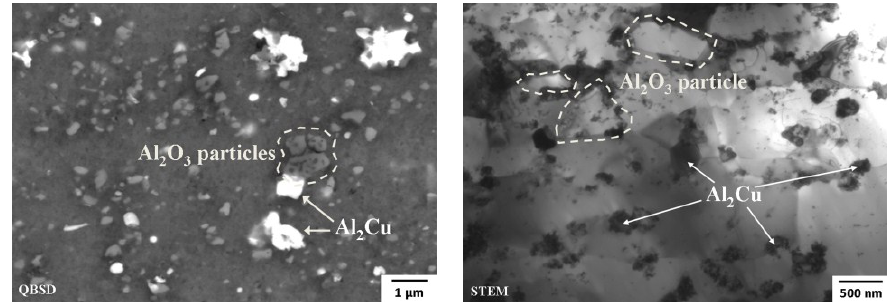
Figure 2. Electron back scatter diffraction (EBSD) color-coded orientation maps of the unreinforced matrix material conditions: ( a ) non-ECAP-processed and ( b ) after one ECAP pass. In the shear bands, the grain size is considerably reduced after one ECAP pass. By contrast, the initial grain size outside the shear bands is almost maintained.